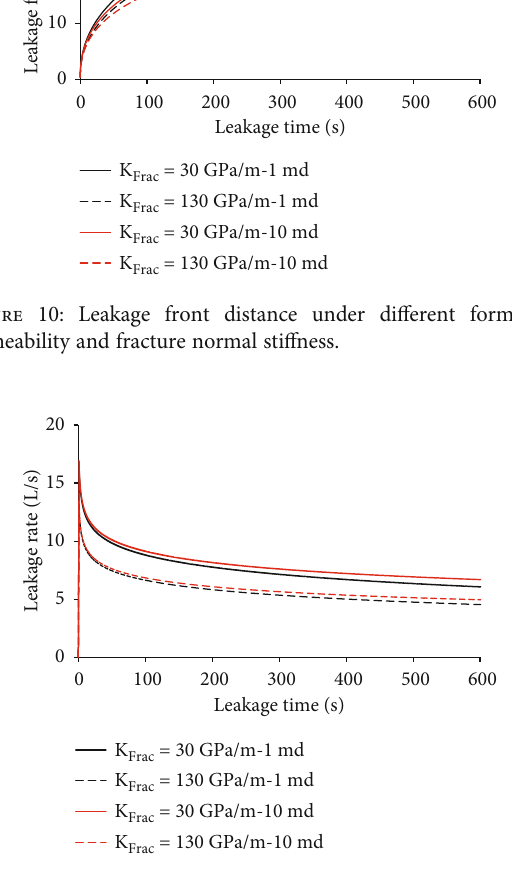
Figure 11: Leakage rate under di ff erent formation permeability and fracture normal sti ff ness.